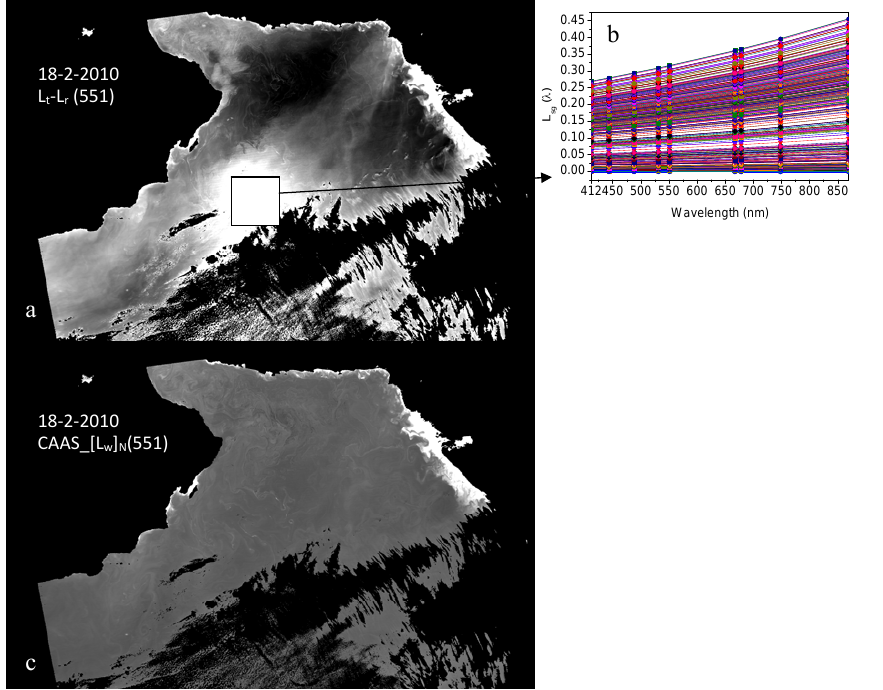
Fig. 8. Rayleigh-corrected radiance (a) , sun glint spectra (b) and water-leaving radiance (c) from MODIS-Aqua imagery of 18 February 2010 (Arabian Sea) processed using the CAAS algorithm.